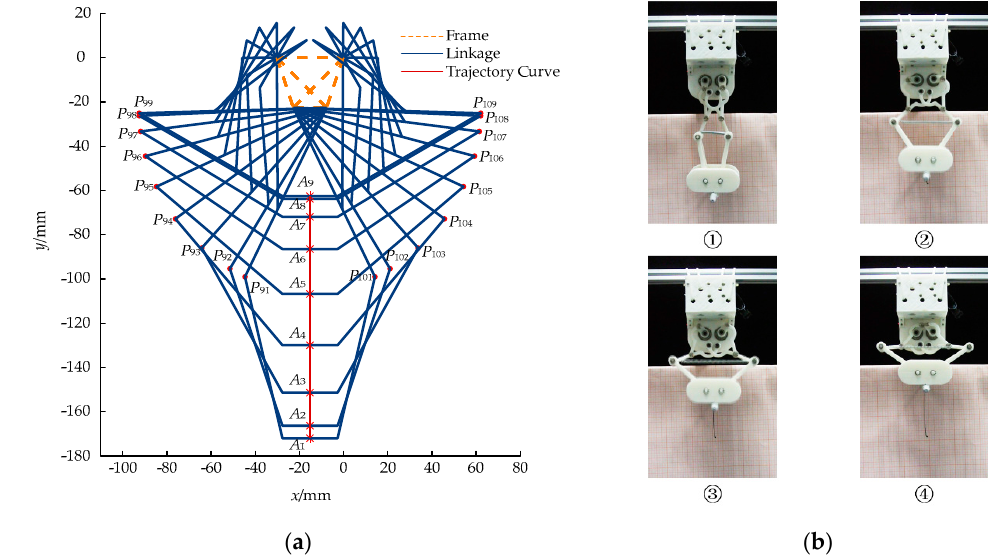
Figure 13. ( a ) Theoretical movement posture of the hopping mechanism at the energy storage phase. ( b ) Experimental process diagram of trajectory reproduction at energy storage phase. ① represents the initial position; ② and ③ represents the general position; ④ represents the end position.